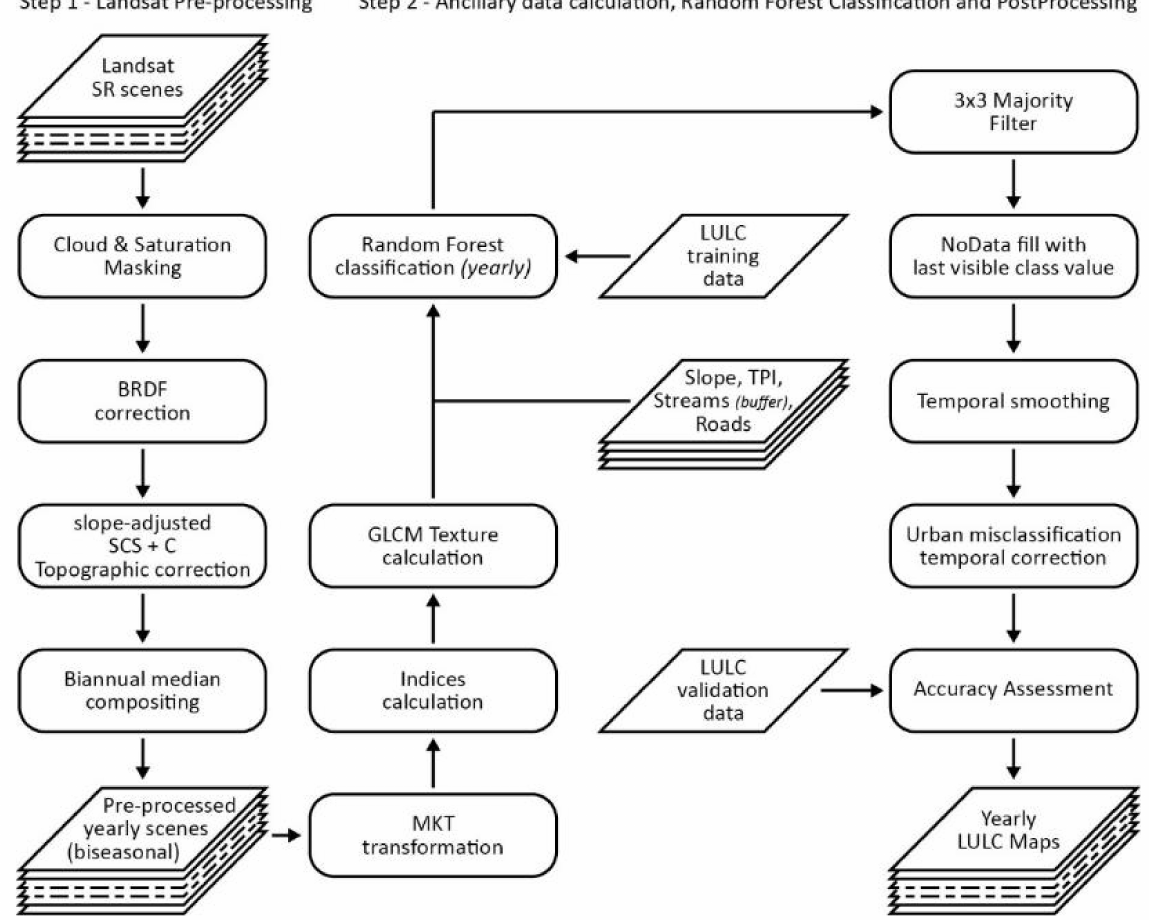
Figure 2. Google Earth Engine workflow scheme for yearly LULC classification (Pre-processed yearly biseasonal Landsat scenes were exported between each step not to overflow the server’s computing capacities